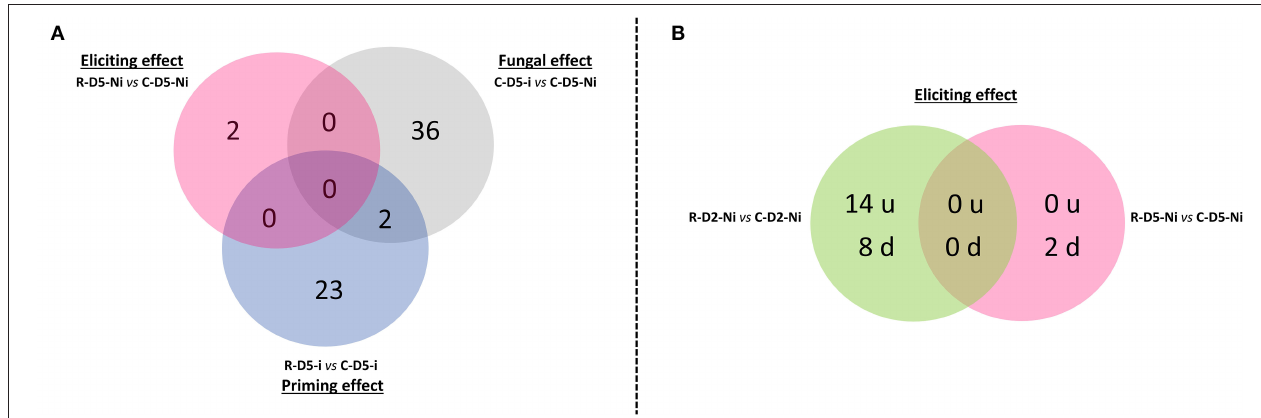
FIGURE 2 | Venn diagrams of the number of differentially expressed genes observed during Rh-Est-C12 eliciting and priming, as well as Z. tritici effects. (A) The eliciting (R-D5-Ni vs. C-D5-Ni), fungal (C-D5-i vs. C-D5-Ni), and priming effects (R-D5-i vs. C-D5-i) on the number of differentially expressed genes in wheat third leaves (Cv. Alixan) were compared at 5 days after treatment with Rh-Est-C12, i.e . at 3 days after infection with Z. tritici (T02596 strain). (B) The effect of the rhamnolipid alone, applied at 500mg.L − 1 , on the number of upregulated (u) and downregulated (d) genes was explored 2 and 5 days after treatment (R-D2-Ni vs. C-D2-Ni and R-D5-Ni vs. C-D5-Ni, respectively). C stands for a mock treatment while R is for Rh-Est-C12 application; Ni relates to mock-inoculated wheat, while i means inoculated plants with Z. tritici ; D2 or D5 indicates sampling dates of the third-leaves corresponding to 2 or 5 days after treatment,